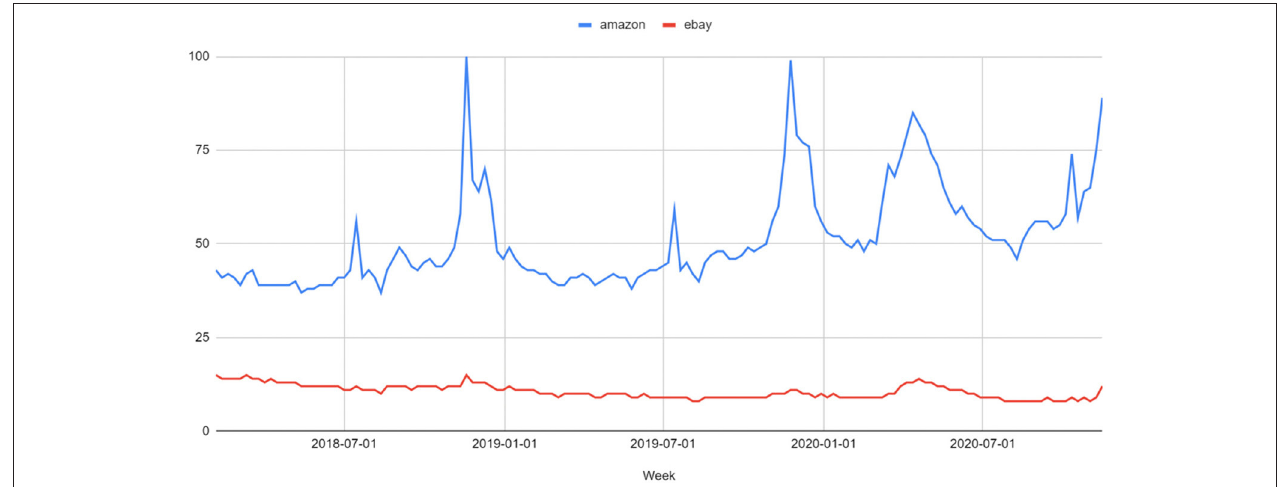
FIGURE 3 | Italian citizens’ web interest in shopping delivery services from November 2017 to November